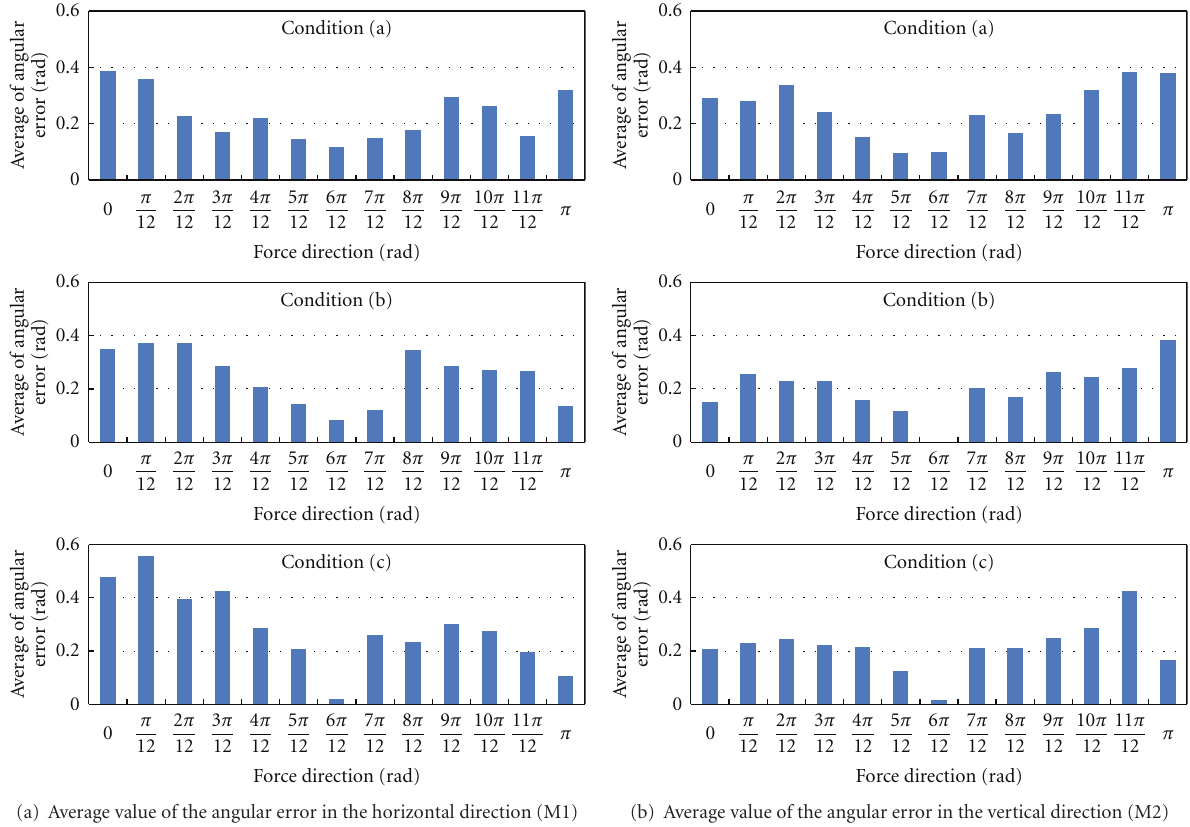
Figure 8: Measurement results of the angular error.